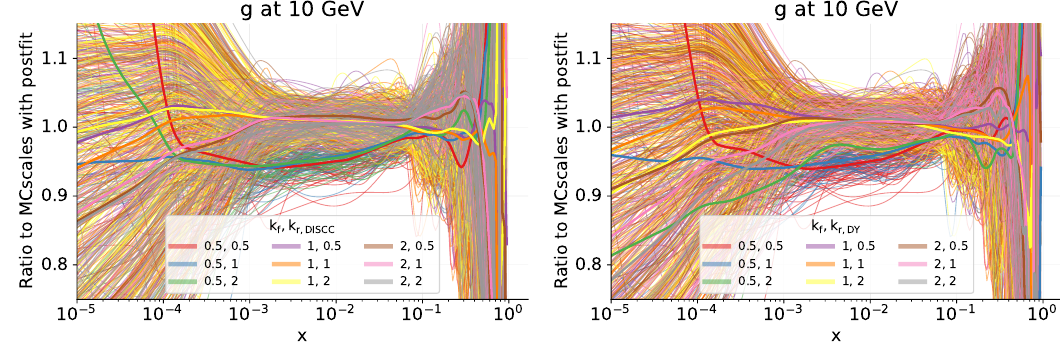
Figure 4 . PDF replicas of the MCscales with postfit set, for the gluon at Q = 10 GeV. Each replica is coloured according to its scale choice, where the numbers in the legend correspond to ( k f , k r ), where k r corresponds to the renormalisation scale for the DIS CC predictions (left panel) or to the one for the DY predictions (right panel). The colouring of the scales is done according to the scales of two different processes included in the fit: the left-hand plot shows the values of the scales for DIS CC and the right-hand plot shows them for DY. The bold lines indicate the average over all replicas for the corresponding scale choice. The plot is normalised to the central replica so that deviations from the central value are